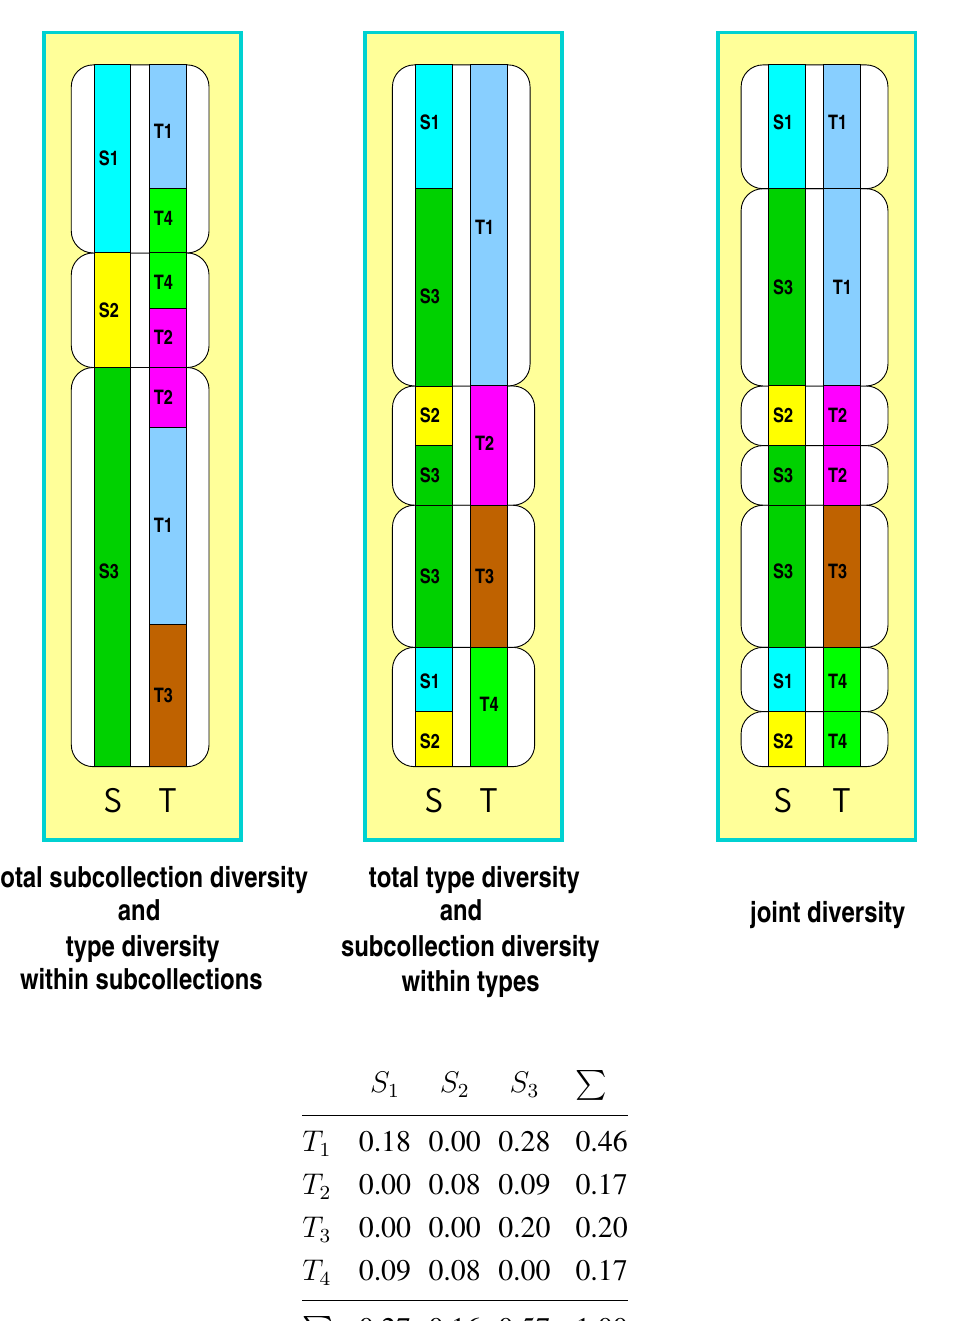
Figure 1. Illustration of the five components of diversity in a subdivided collection (three subcollections S 1 to S 3 , four types T 1 to T 5 ): subcollection diversity (left panel, left column), type diversity within subcollections (left panel, right column), type diversity within the total collection (middle panel, right column), subcollection diversity within types (middle panel, left column), joint type-subcollection diversity (right panel). The table provides the type, subcollection, and joint frequencies underlying the